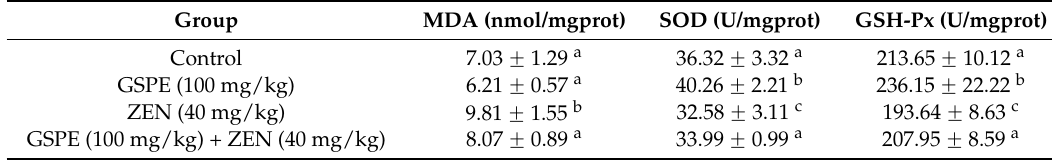
Table 2. Effect of GSPE on liver antioxidant parameters in mice induced by